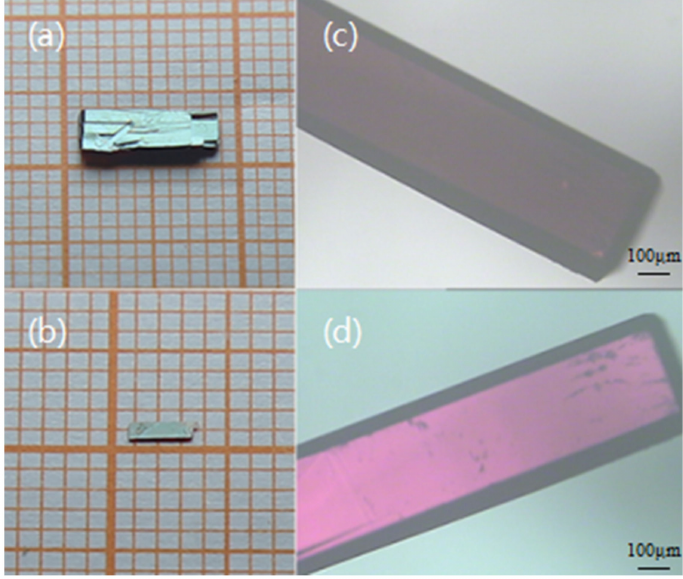
Figure 3. 1-TB single crystals grown in methanol / acetonitrile (1:1 vol / vol) ( a , b ), 1-TB (b) dark field in the case of orthogonal polarized light ( c ), and reaching maximum transmittance after rotating 45 ◦ ( d ).